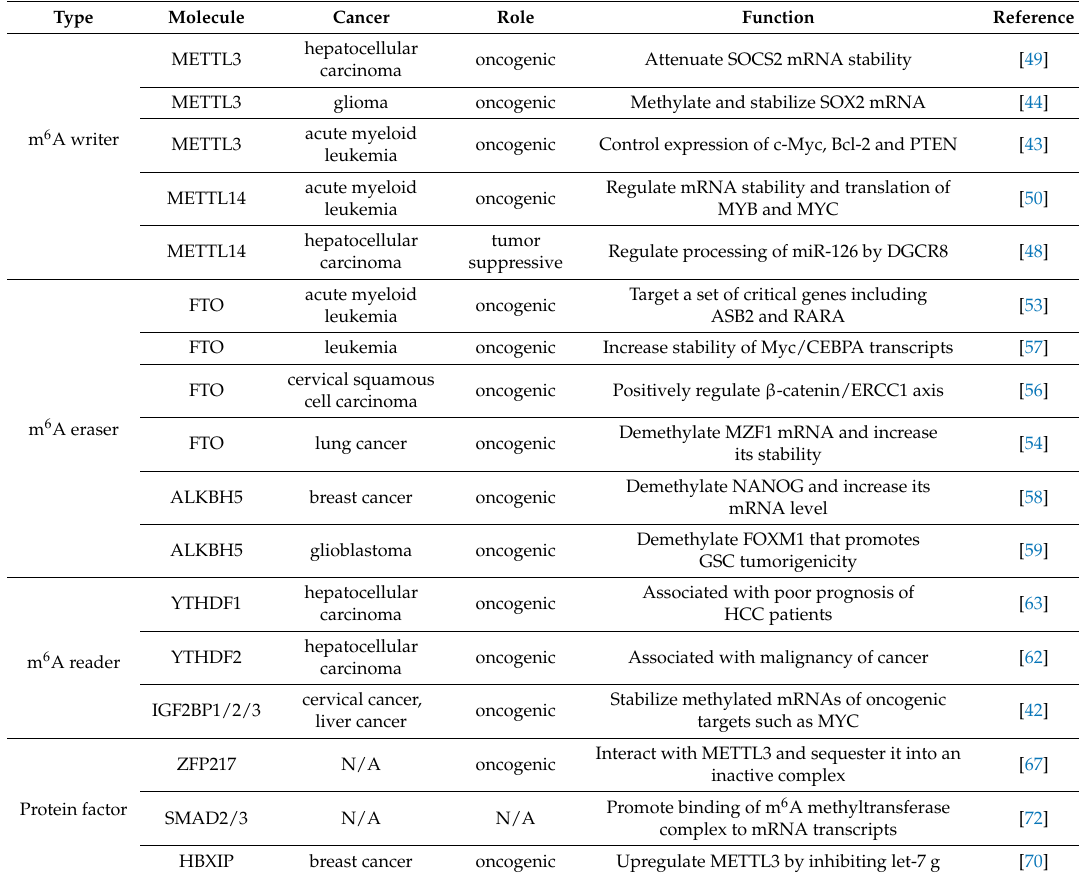
Table 1. Function of m 6 A regulatory factors in various